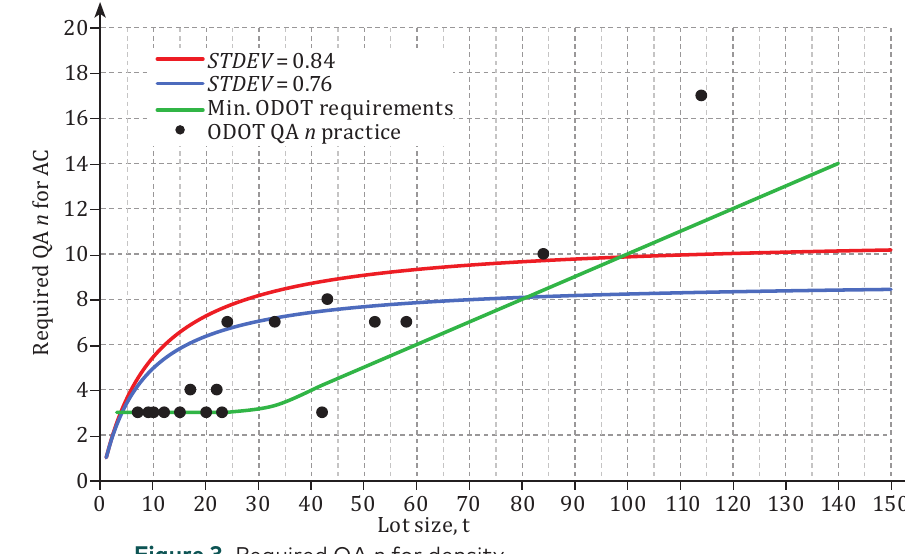
Figure 3. Required QA n for density Table 4. The proposed n based on 0.76 and 0.84 STDEV